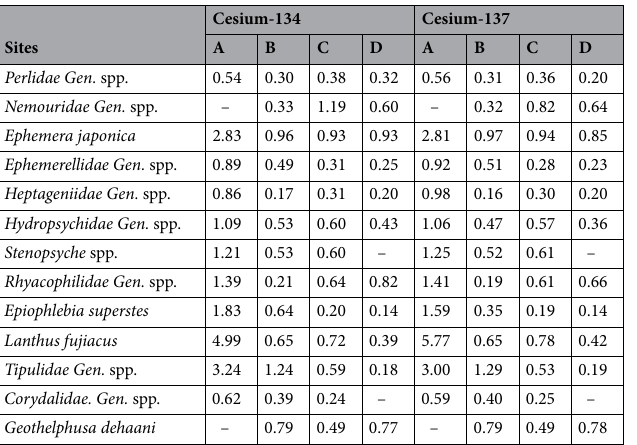
Table 5. Transfer coefficient from litter in 13 groups of aquatic invertebrates at sites A, B, C and D. –: no